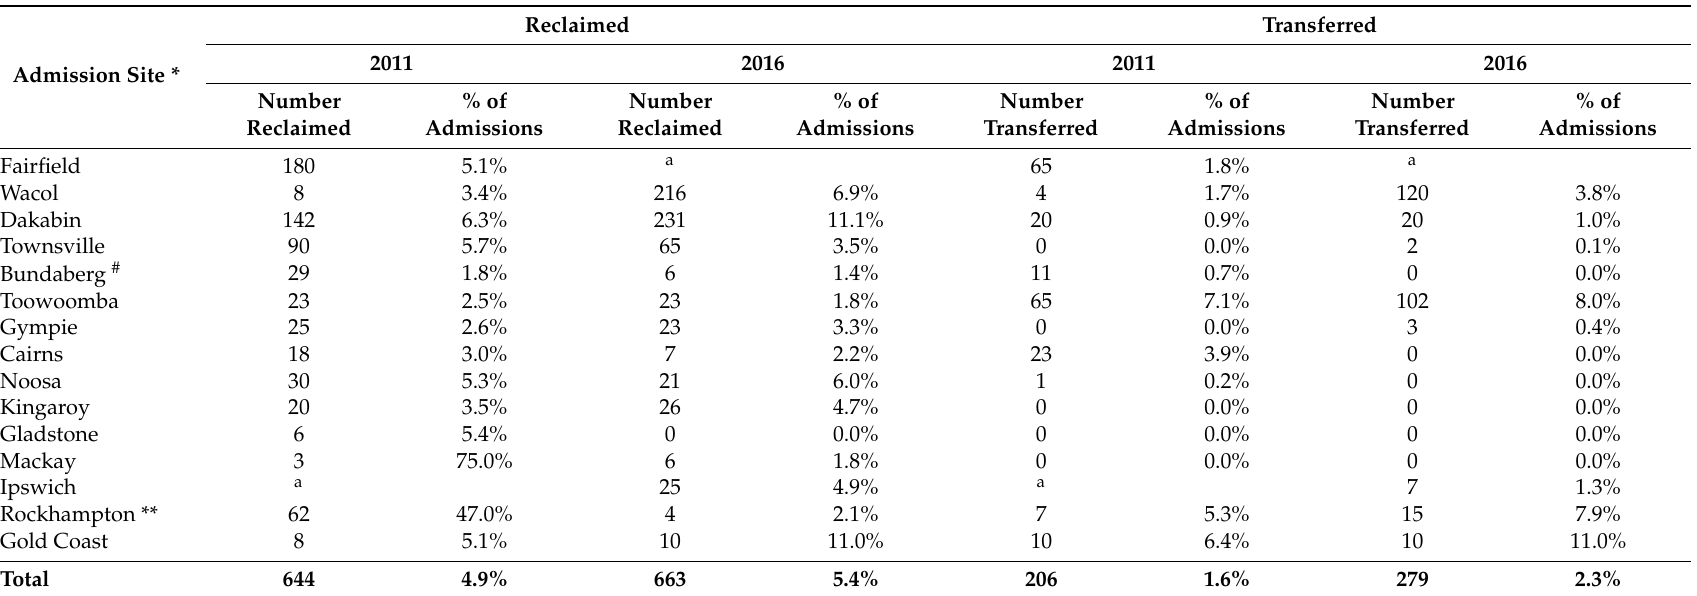
Table A4. Summary of the outcomes ‘reclaimed’ and ‘transferred to rescue group’ by admission site (RSPCA shelter or adoption center) for 2011 and 2016 for cats whose outcome was resolved by the 90th day (‘day 90’; where day 1 was the day the cat was admitted), excluding movements to pet supply stores and RSPCA adoption events in 2011 and 2016. Note: These results differ slightly from those reported on the RSPCA national website [3] because of differences in inclusion and exclusion criteria, and analysis by calendar year rather than final year. For cats moved between RSPCA sites after admission, the outcome occurred at that subsequent site, but it is shown as an outcome for the admission